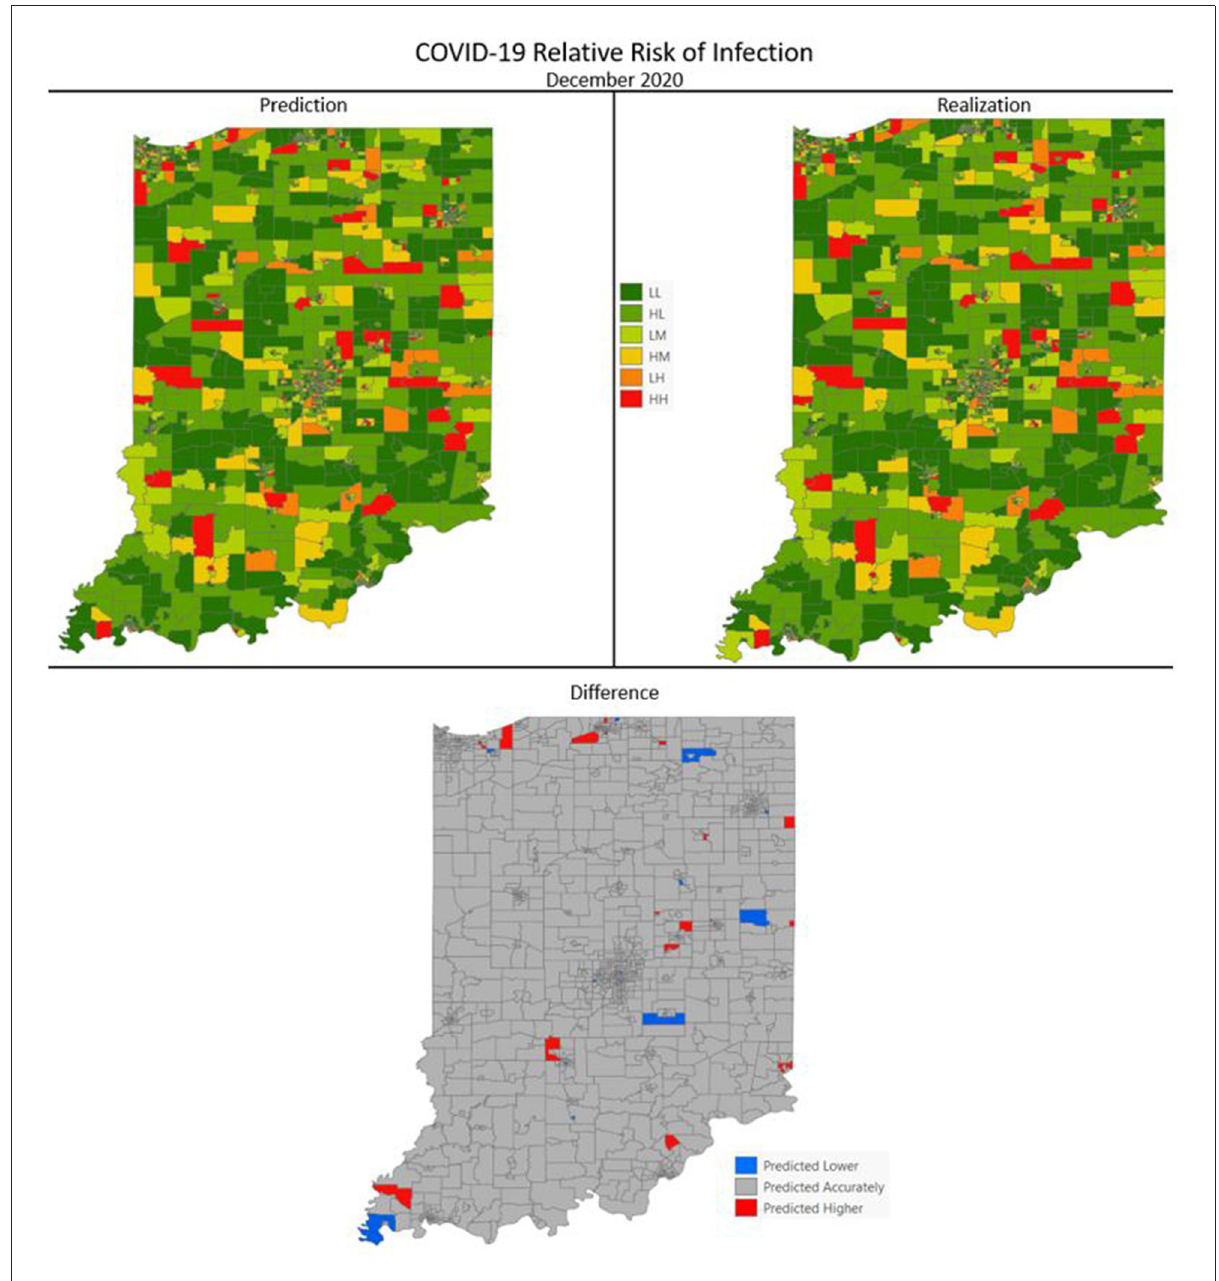
FIGURE9 COVID-19 categorical relative risk infection prediction and realization for December 2020.